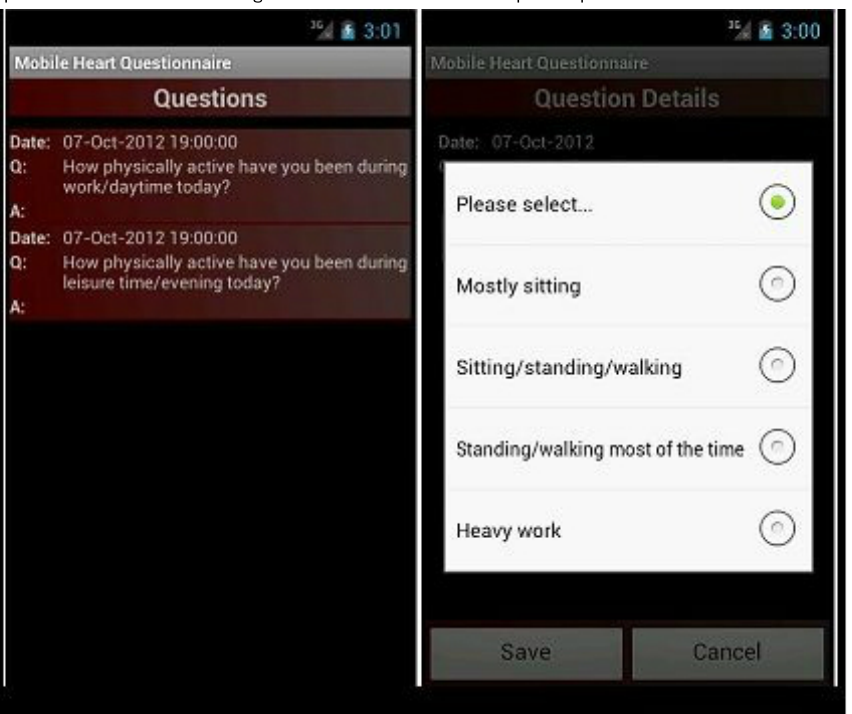
Figure 1. Screenshot of questionnaire and answer categories of the MobilePAL smartphone